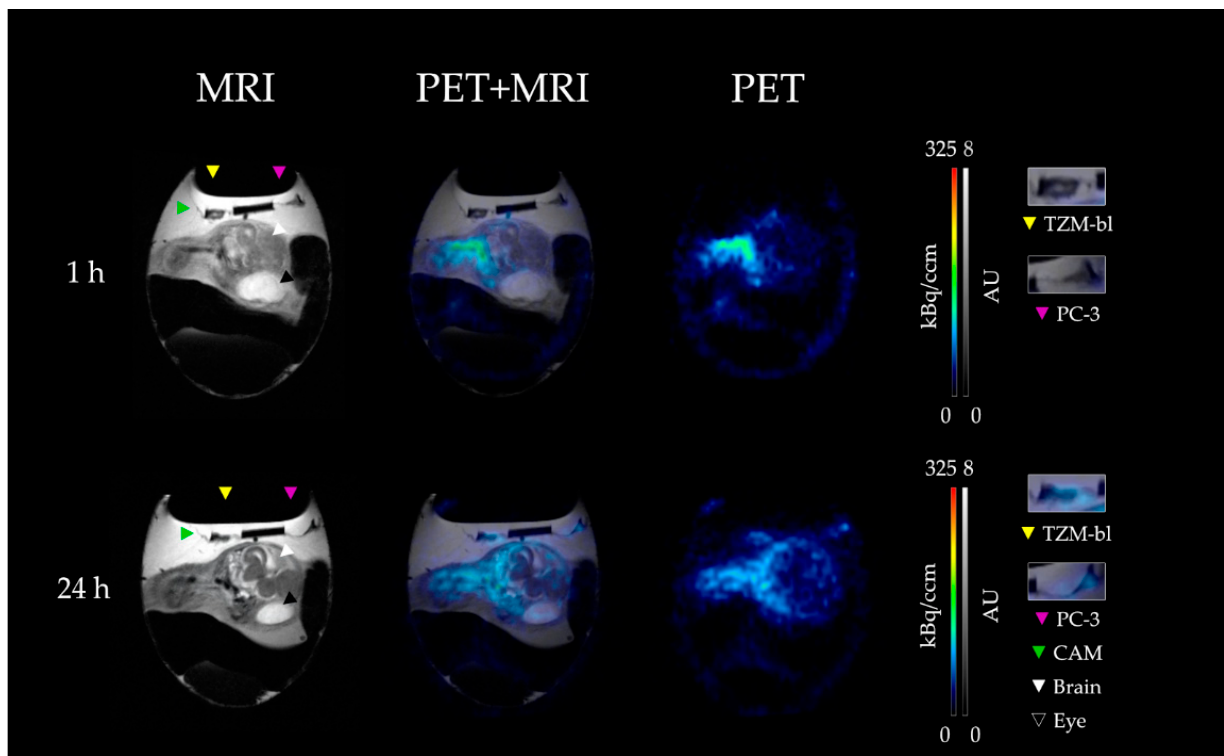
Figure 2. MR and PET images, including fusion images of the CAM model 1 h and 24 h after injection of [ 89 Zr]Zr-DFO-HSA. In the T2-weighted sequence ( left ), the anatomy of the chick embryo and the tumors were clearly visible. The biodistribution of the radioligand could be observed by PET ( right ) and assigned to the respective organs in the corresponding fusion image ( middle ). Magnified images of the tumor region are separately depicted on the right. In the TZM-bl (left tumor, yellow arrow) and PC-3 (right tumor, magenta arrow) after one hour ( top row ), no accumulation of [ 89 Zr]Zr-DFO-HSA could be detected, while after 24 h ( bottom row ), a clear accumulation was noted in both tumors. In the brain region (white arrow), no/only a low signal was observable after 1 h and 24 h. Thus, [ 89 Zr]Zr-DFO-HSA displayed no unspecific accumulation in regions with intact barriers but in regions influenced by the EPR effect. The CAM (green arrow) and the eye of the embryo (black arrow) are additionally highlighted.